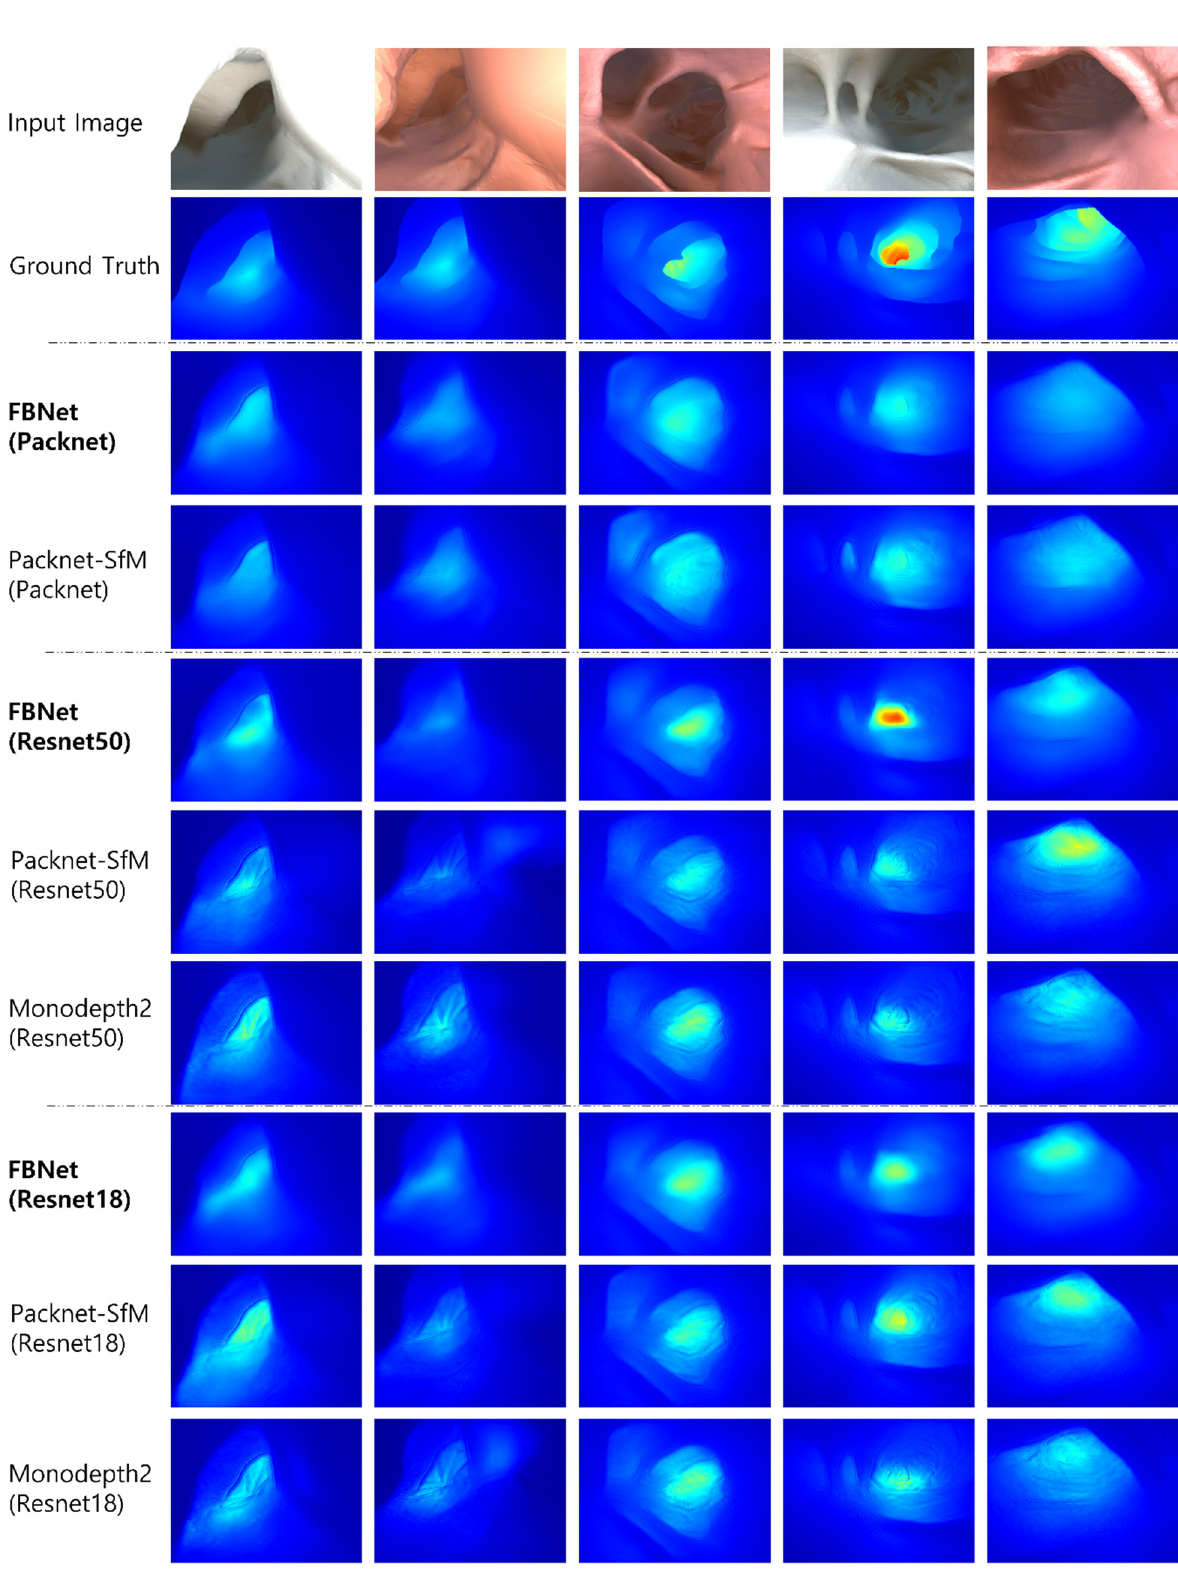
Figure 6. Qualitative results for depth estimation. Compared to other methods, FBNet has less noise due to texture. This is because geometry consistency information using a depth feedback network and depth reconstruction loss were used.